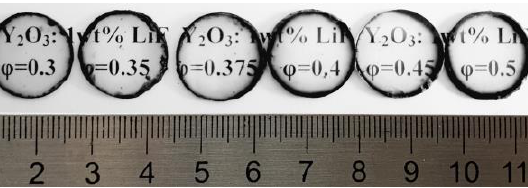
Figure 5. Appearance of the Y 2 O 3 ceramics with different SHS precursor compositions  and 1wt.% LiF sintering additive. LiF sintering